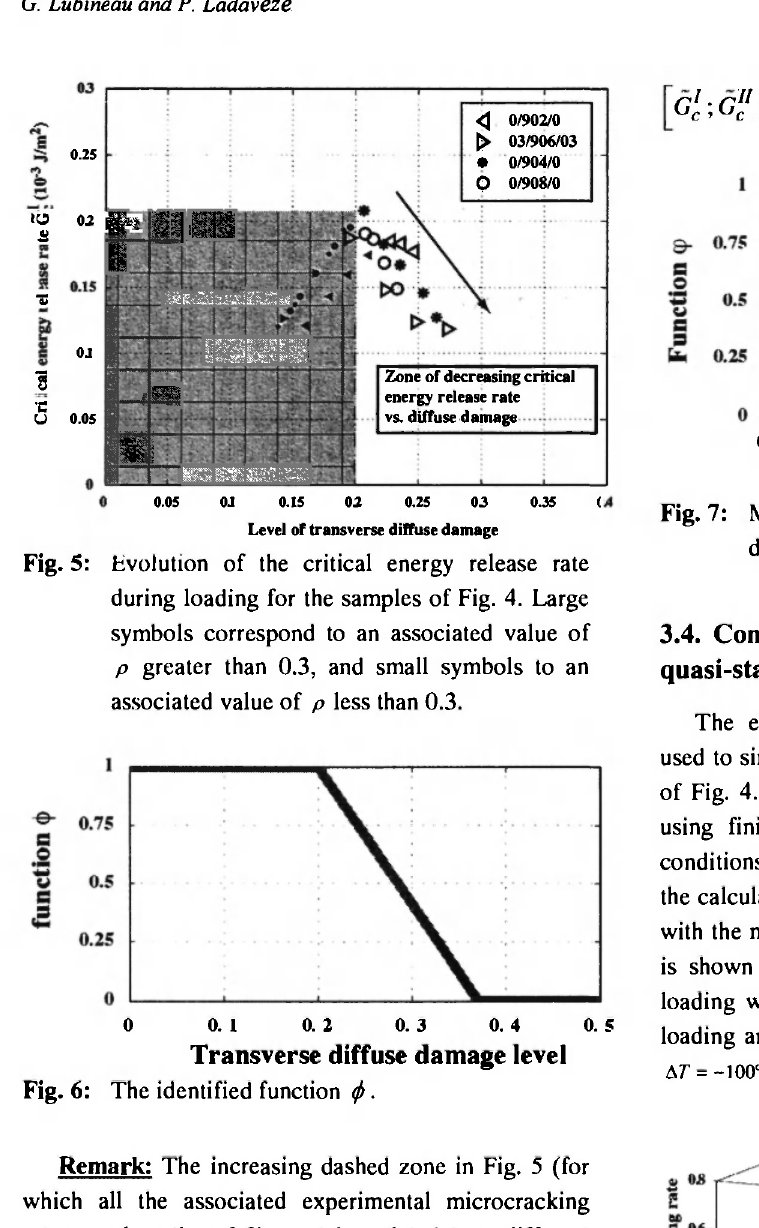
Fig. 6: The identified function φ.